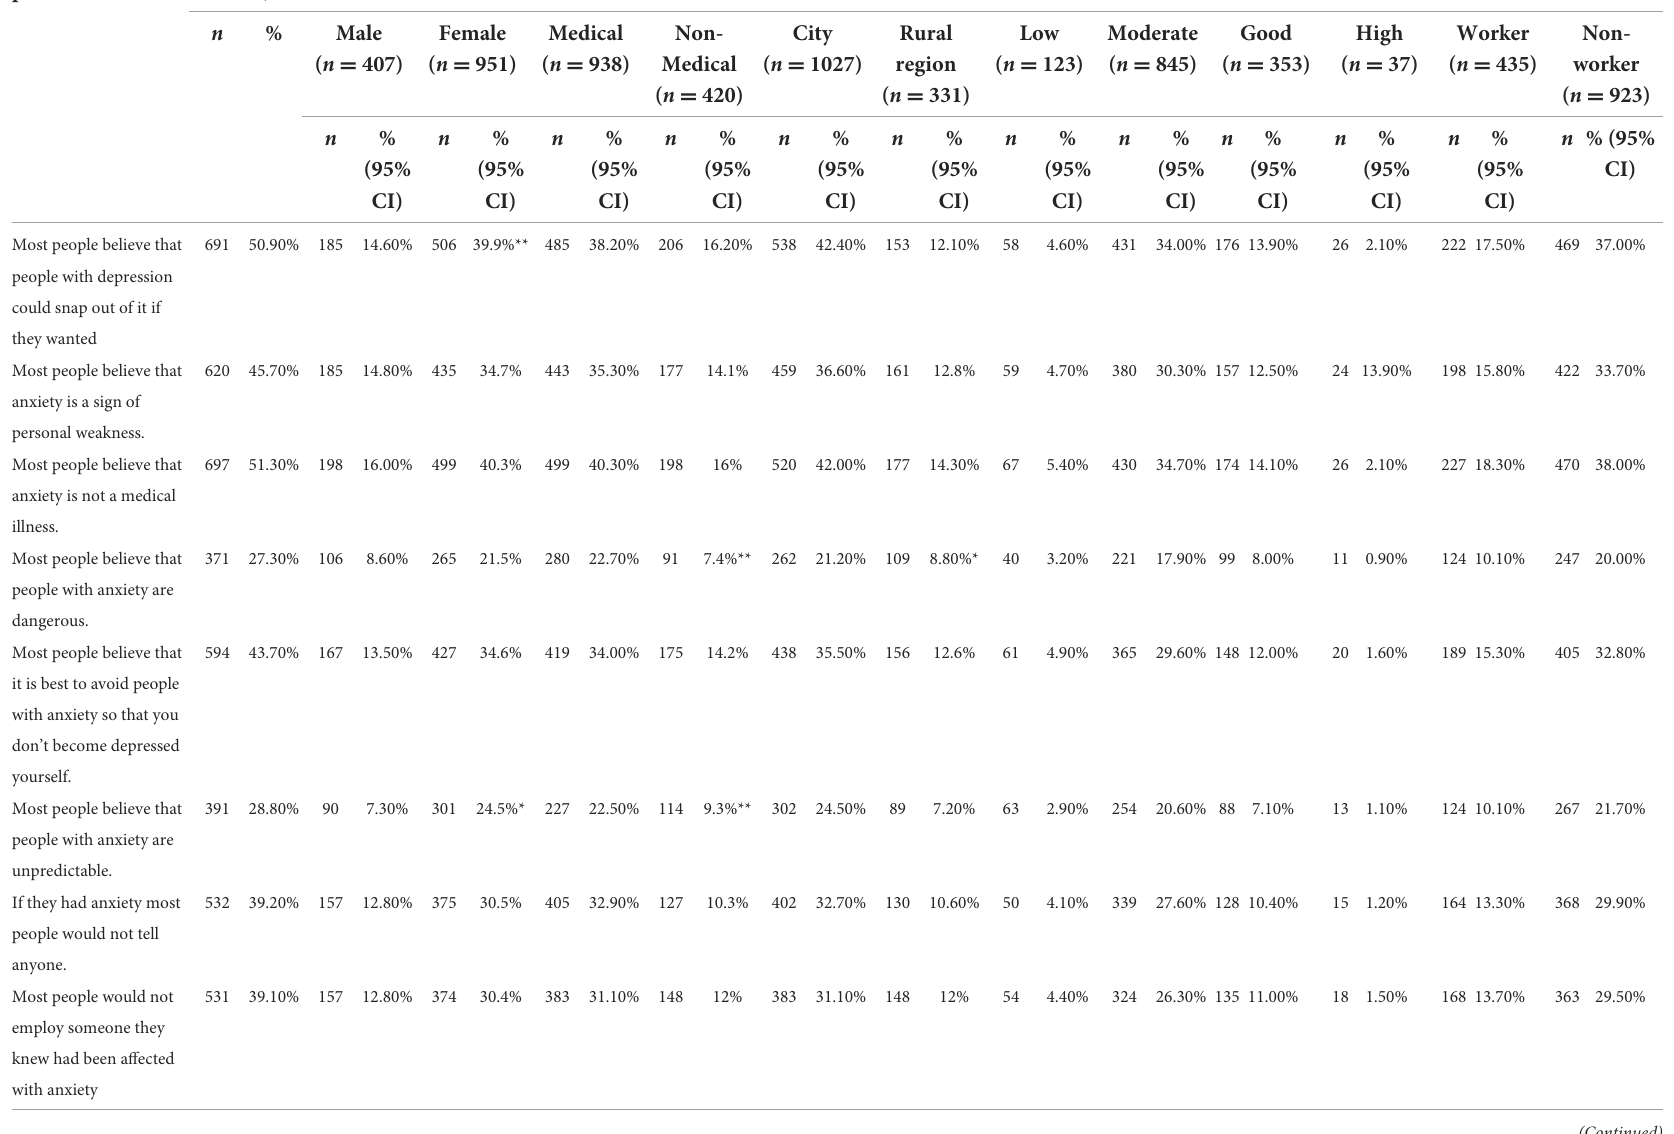
TABLE 3 Percentage of participants who “agree” or “strongly agree” with perceived stigma toward GAD patient scale statements. Statement about perceived